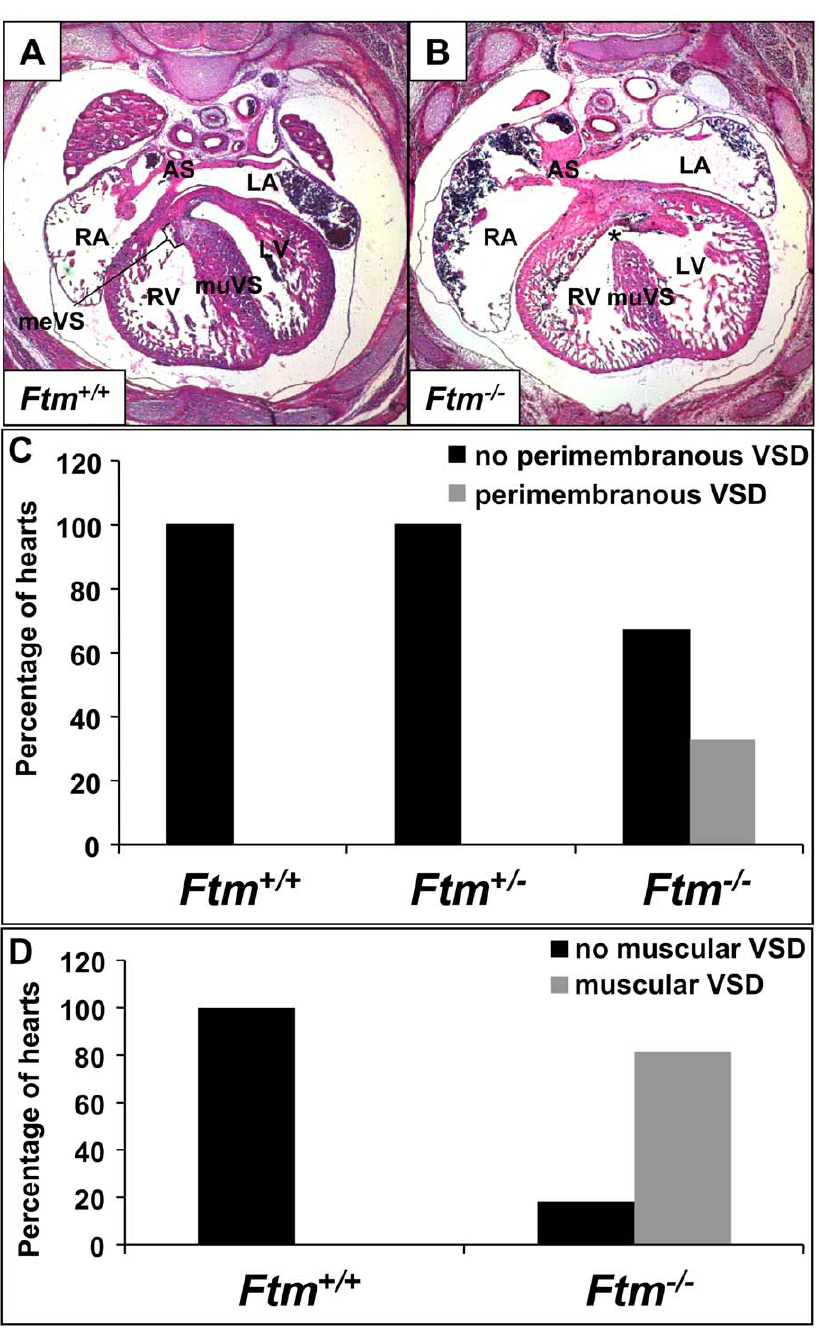
Figure 1. Ftm -deficient murine embryos show perimembranous and muscular ventricular septal defects. (A, B) Hematoxylin and Eosin stainings at E14.5 on transverse heart sections. (A) In wild-type mouse embryos, the ventricular septum consists of a muscular part (muVS) and a membranous part (meVS). (B) In Ftm 2 / 2 embryos, the muscular VS displays a shorter and thinner shape and the membranous VS is missing (indicated by the asterisk) representing a perimembranous ventricular septal defect. (C) While in Ftm + / + (n=23) and Ftm + / 2 mice (n=21) the heart develops normally, 33% of Ftm 2 / 2 mice (n=27) show perimembranous ventricular septal defects. This statistics is based on investigations of mice at E13.5, E14.5, E15.5, E16.5 and E17.5. (D) Ftm + / + mouse embryos (n=23) do not suffer from muscular ventricular septal defects. 81.5% of all analyzed Ftm 2 / 2 embryos (n=27) display muscular ventricular septal defects. Embryos at E13.5, E14.5, E15.5, E16.5 and E17.5 were examined in this context. LA, left atrium; RA, right atrium; LV, left ventricle; RV, right ventricle; meVS, membranous ventricular septum; muVS, muscular ventricular septum; AS, atrial septum.